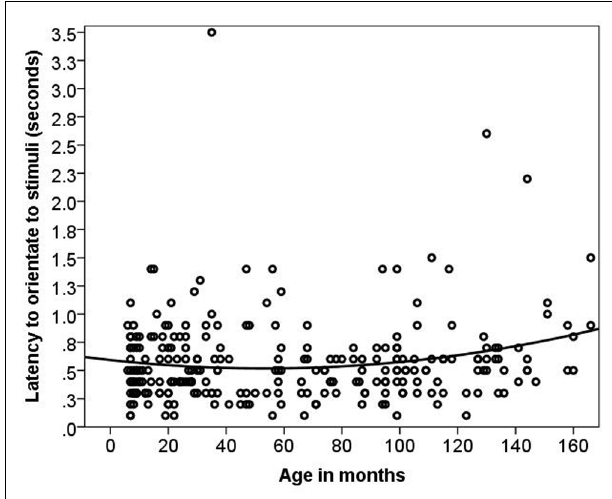
FIGURE 2 |The quadratic relationship between latency to orient and age in